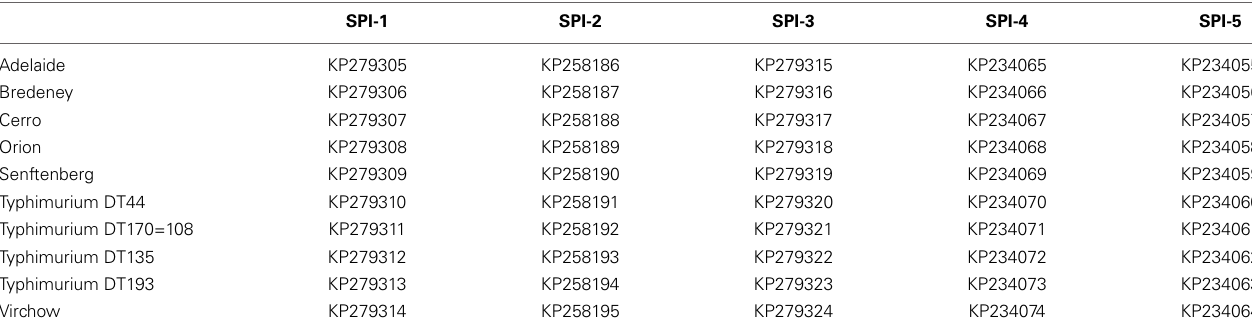
Table 2 | NCBI accession numbers for pathogenicity island